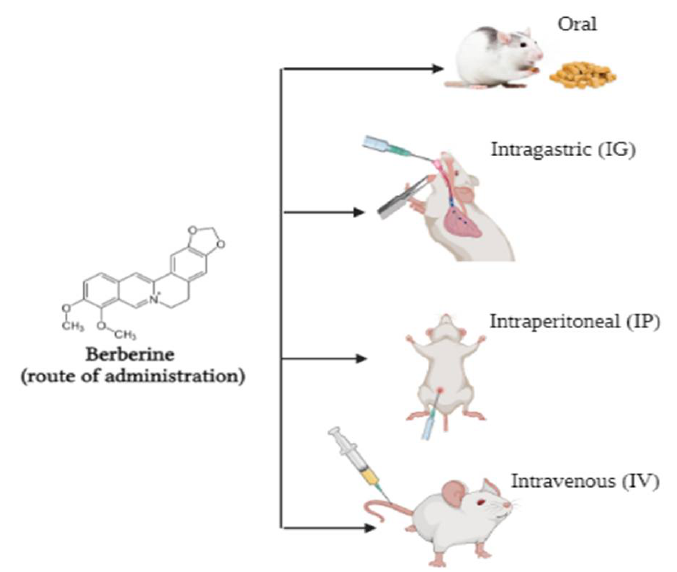
Figure 4. Different routes of Berberine administration. Common routes of BBR administration include oral, intragastric (IG), intraperitoneal (IP), and intravenous (IV).